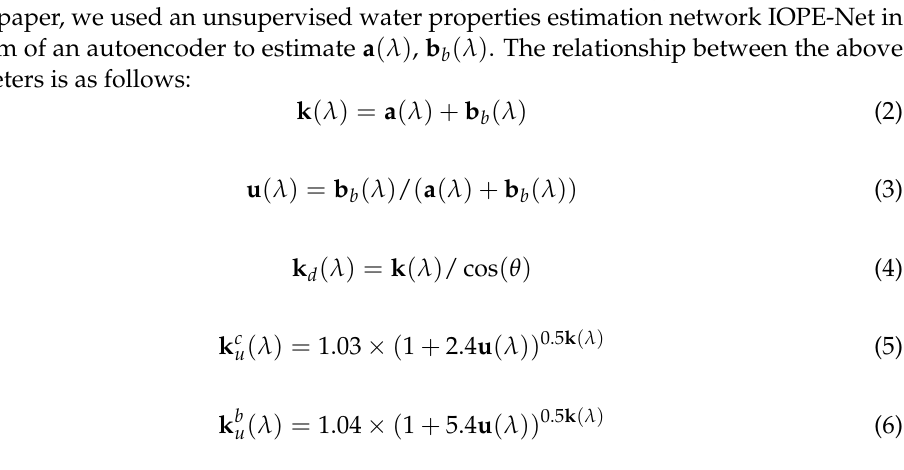
( λ ) and k b ( λ ) are determined by the IOPs of water: u u